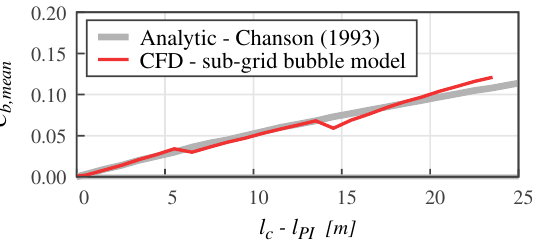
Figure 12. Spillway chute—bubble mean volumetric concentration against Chanson [27] analyti- cal solution.